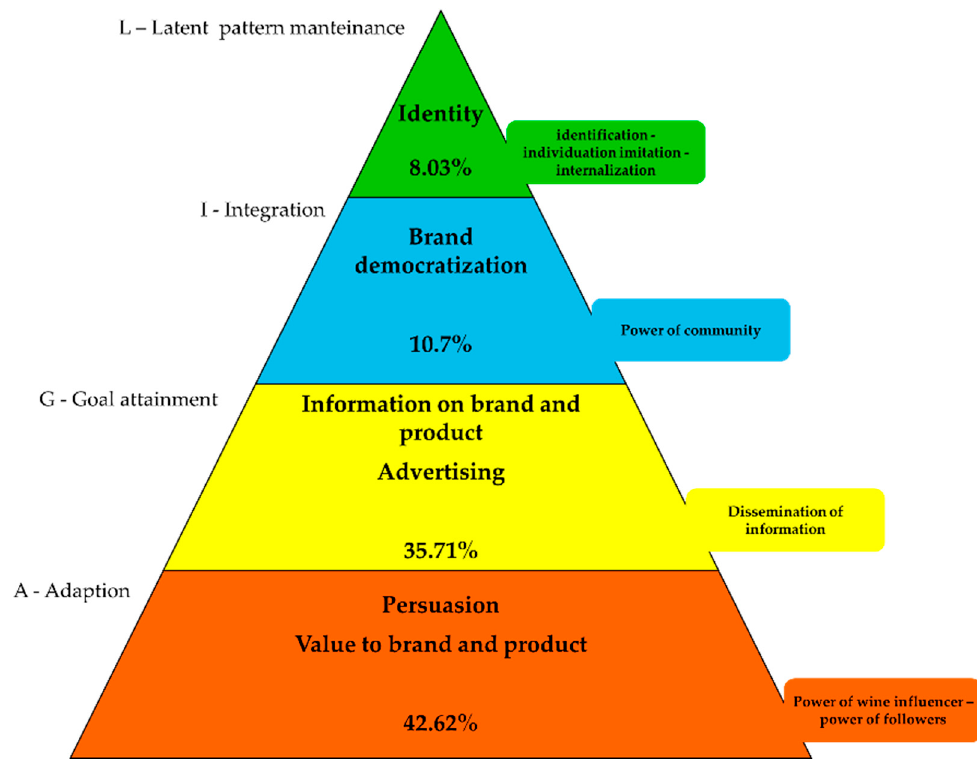
Figure 4. Authors’ presentation of the AGIL scheme with the dimensions and sub-dimensions of the Wine Influencer ‘s Communication Model in Instagram and weight of each dimension.